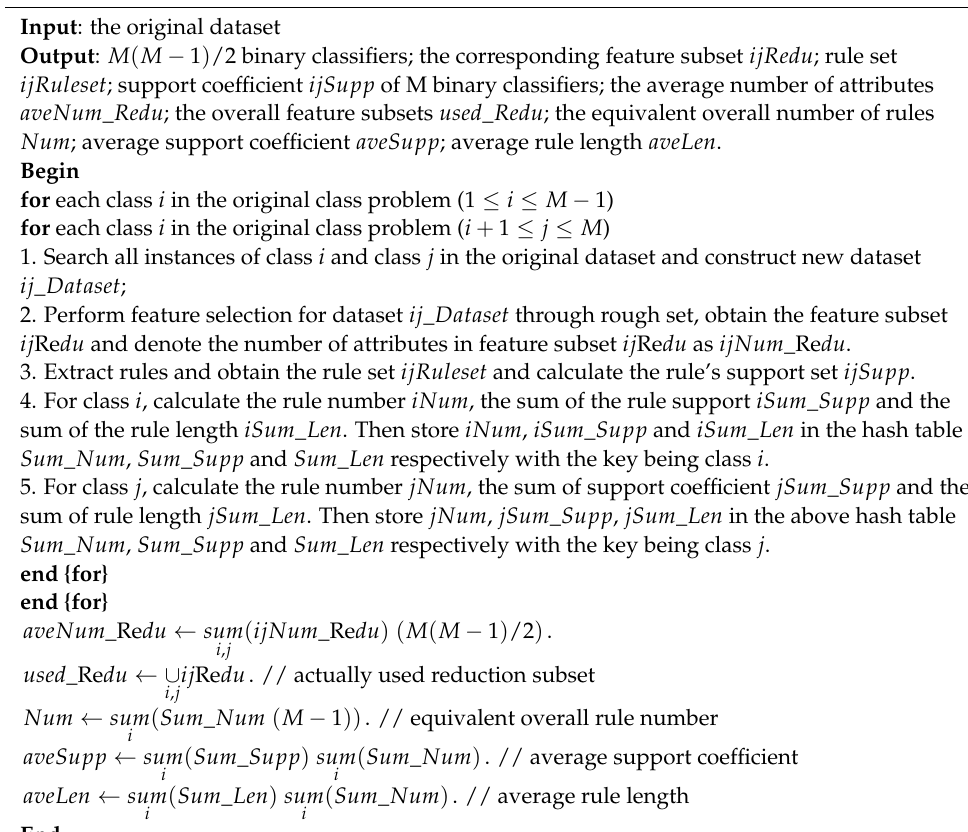
Algorithm 2 Binary classifier construction procedure based on OVO